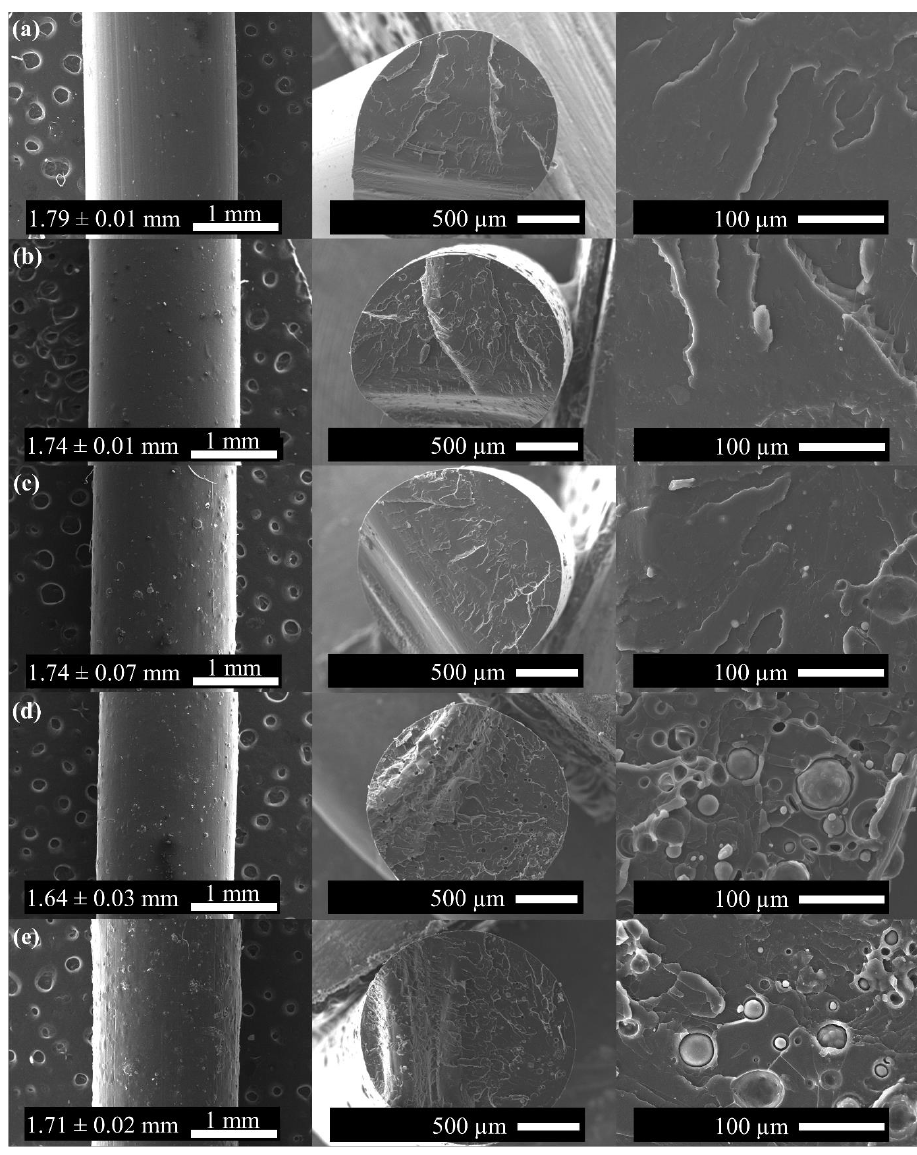
Figure 3. SEM images of ( a ) neat PLA, ( b ) 1.2 wt% Mg, ( c ) 5 wt% Mg, ( d ) 10 wt% Mg, and ( e ) 15 wt% Mg filaments and their fracture surfaces.